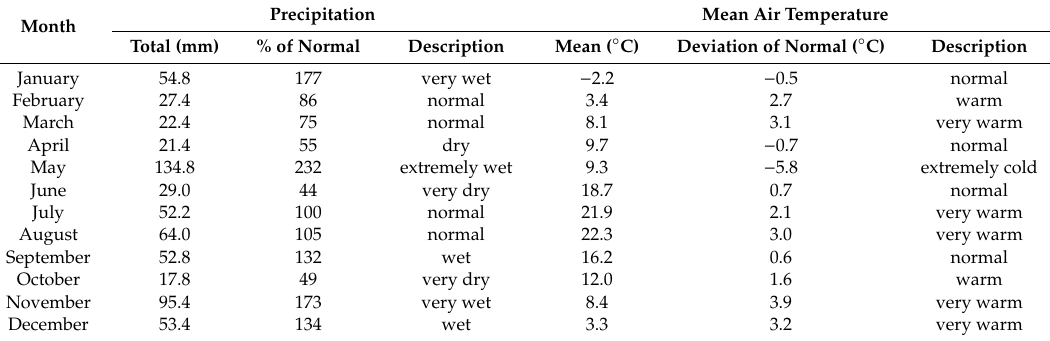
Table 3. Evaluation of monthly precipitation and mean air temperature normality in 2019 as compared to the climatic normal (CN) 1960–1991